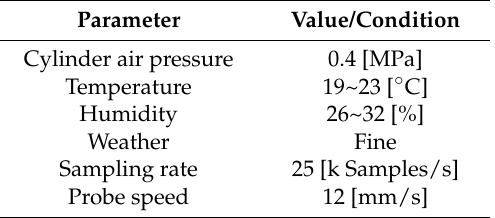
Table 2. Texture evaluation conditions for the samples.